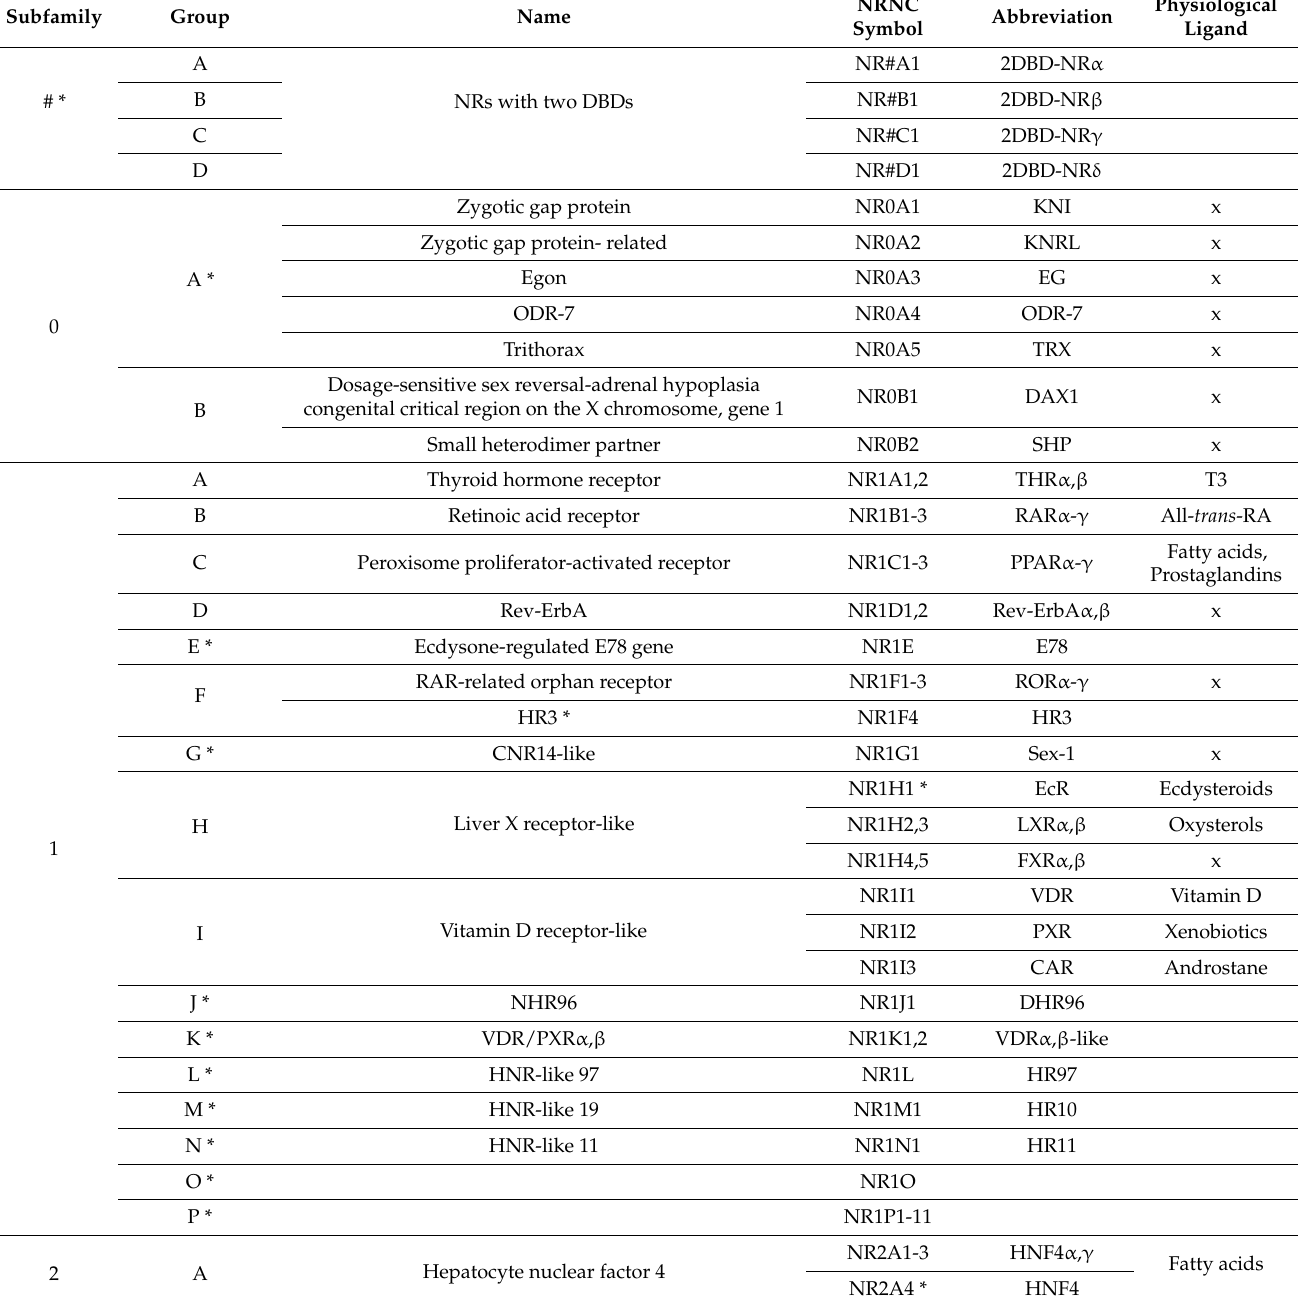
Table 1. Nuclear receptor (NR) complements characterized in metazoan